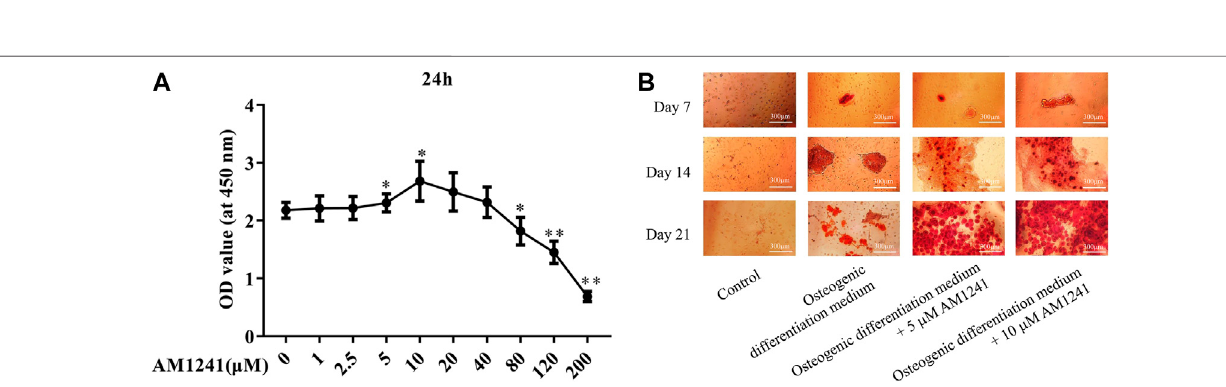
FIGURE 1 | Preparation of hydrogels. (A) SEM images of PEGDA (molecular weight: 700) + DTT hydrogel catalyzed by 0.07 M borax. Sample was prepared by lyophilization. (B) Hydrogelformed fromPEGDA(0.14 mM/ml) andDTT(0.14 mM/ml). Solutionwasproduced afterheatingto80 ° C.Hydrogelreformed after coolingthe solution at 25 ° C.